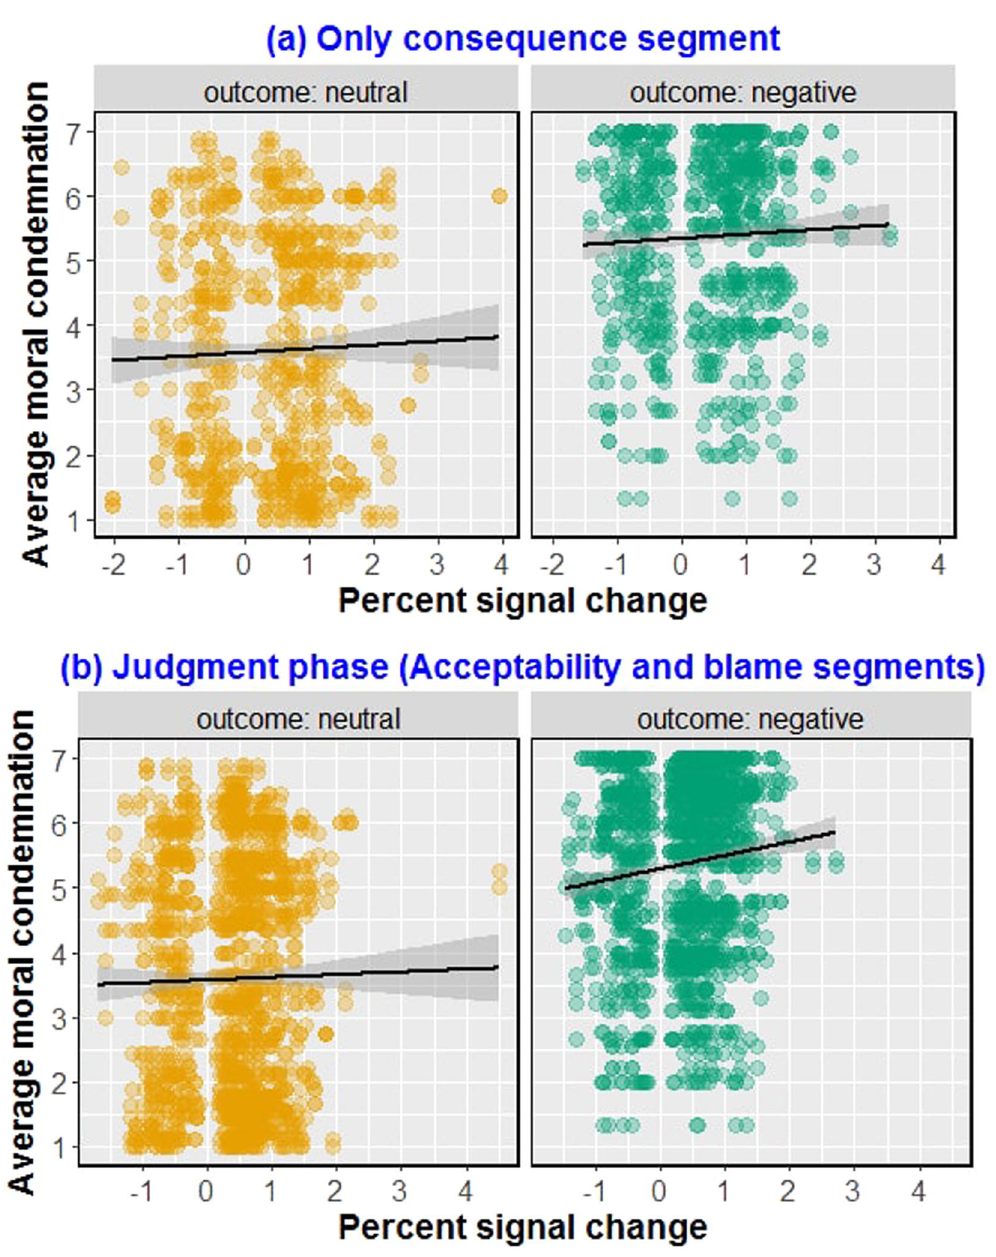
Figure 9. Brain-behavior correlation. The degree to which the empathy network was active (Percent Signal Change) while ( a ) reading information about harmfulness of outcomes and ( b ) providing ratings on judgments predicted the severity of moral judgments for actors who caused harmful